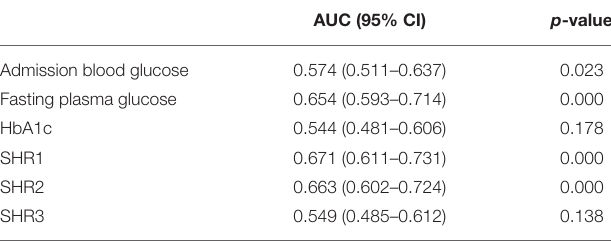
TABLE 3 | Comparison of the baseline characteristics and outcomes between subgroups stratified according to the SHR1 cutoff.